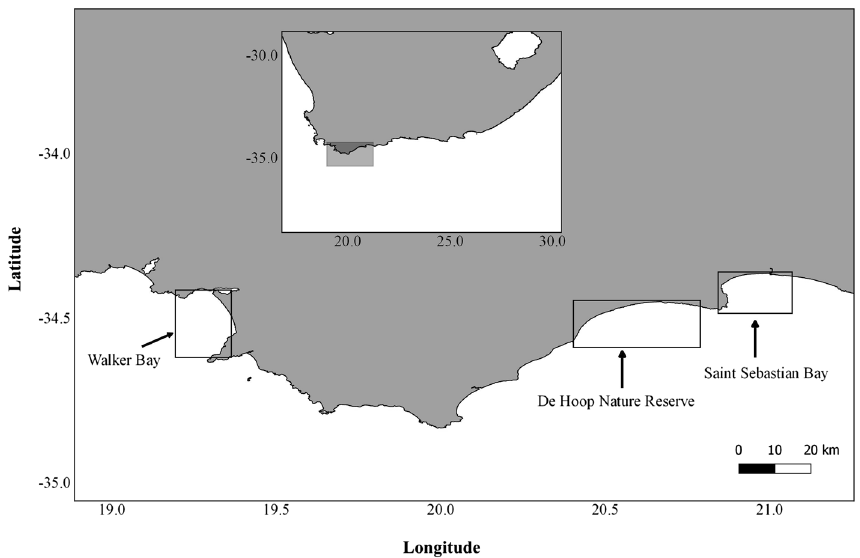
Figure 1. Map of study areas in South Africa. Sample collection in the Early Period took place in De Hoop Nature Reserve, whereas sampling in the Late Period took place in Saint Sebastian Bay and Walker Bay (created in QGIS